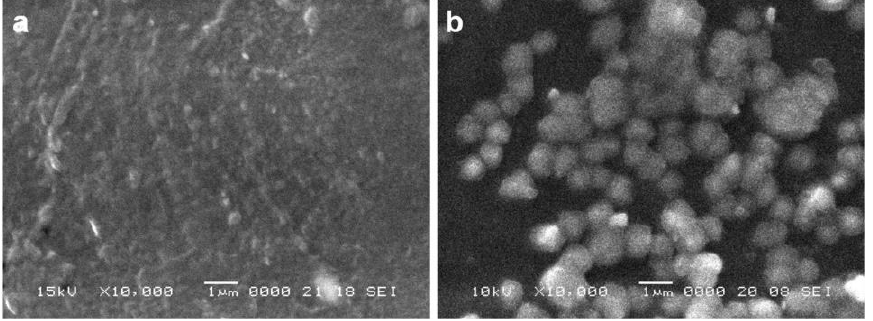
Figure 3. SEM images of multilayer BSA gel microparticles, magnification of 1000× ( a ), 5000× ( b ) and 10,000× ( c ).